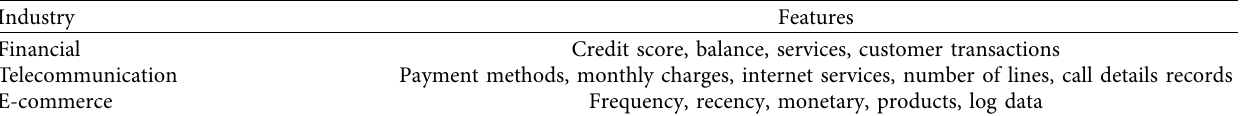
Figure 1: The process of churn prediction. Table 2: Industries and their